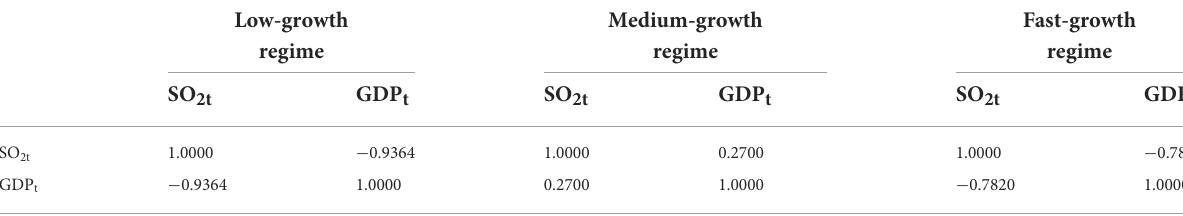
TABLE 3 Estimation of correlation coefficients between the growth rates of SO 2 emission and GDP under different regional systems.